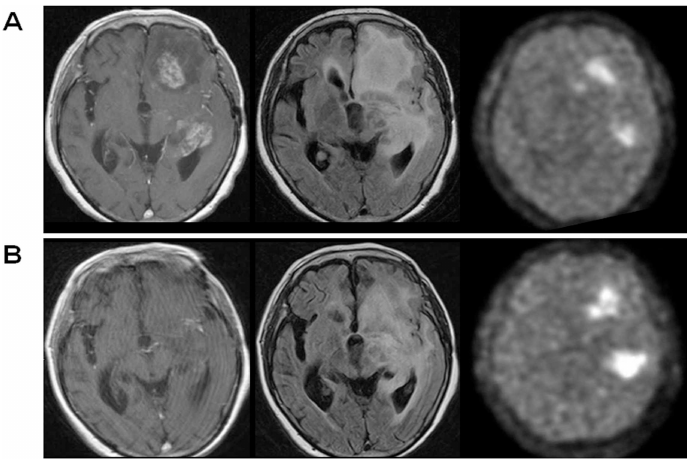
Fig 4. Representative cases of MRI-only responder (Case 2). Gadolinium-enhanced T1-weigted images (left panels), FLAIR images (middlepanels), and FMISO PET images (right panels) are shown, and upper panelsshow the case before BEV treatment and lower panels show the case three courses after BEV administration. After BEV treatment, contrast-enhancedlesion and FLAIR hyperintensity lesionwere significantly decreased, whereasFMISO accumulationwas increasedin both T/N ratio (from 3.70 to 4.81) and volume (from 33.5 mL to 38.5 mL).